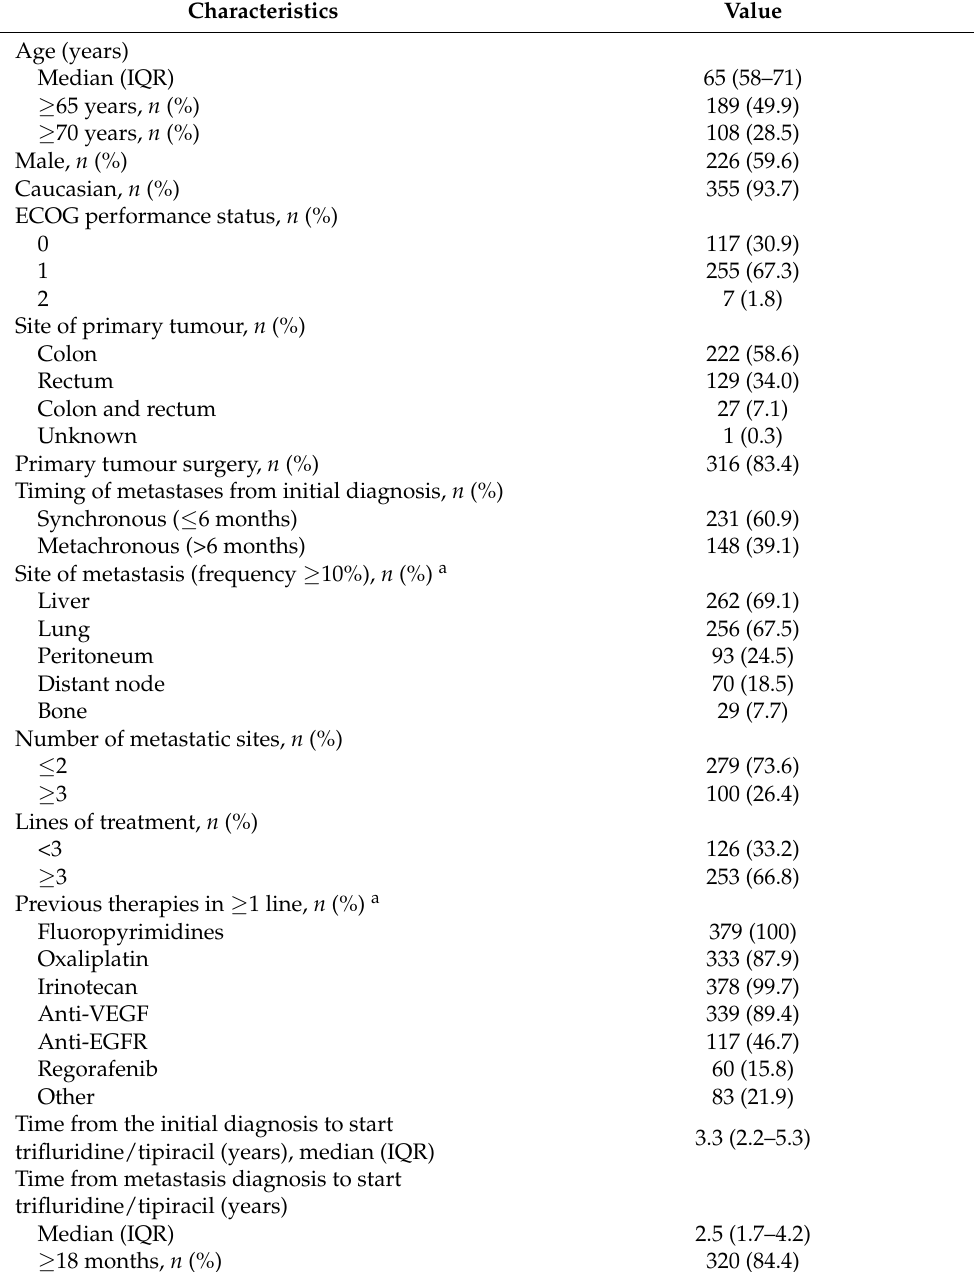
Table 1. Baseline patient characteristics ( n =